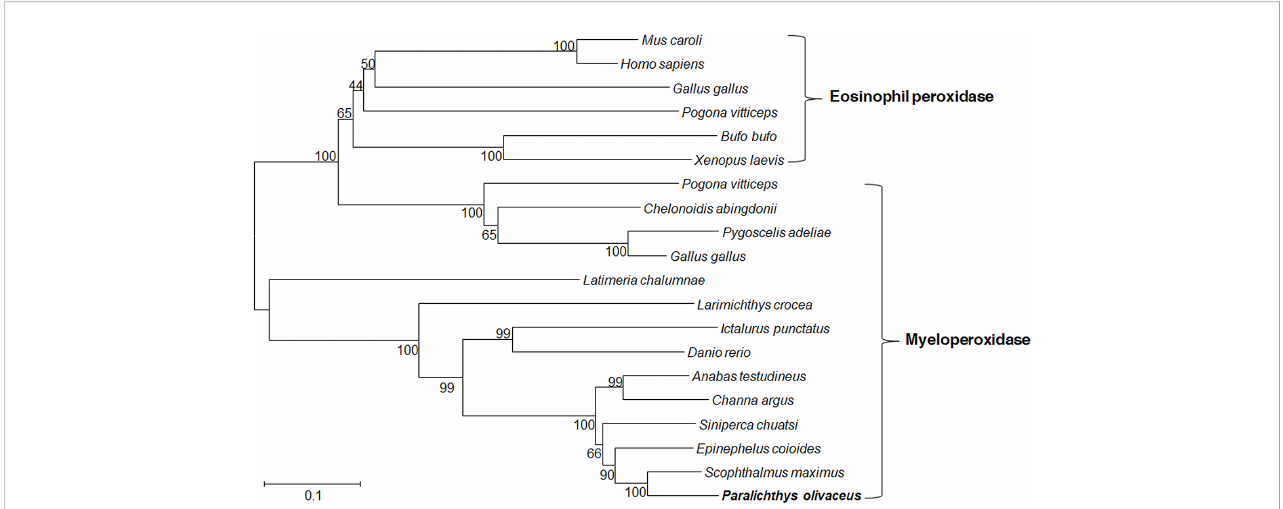
FIGURE 1 Phylogenetic tree showed the relationship between fl ounder MPO/EPO and other vertebrate amino acid MPO/EPO sequences. Numbers in each branch indicate the percentage bootstrap values from 1000 replicates. The accession numbers of MPO and EPO amino acid sequences are as follows, MPO: Paralichthys olivaceus , XP_019938121.1; Siniperca chuatsi , ABC72122.1; Danio rerio , AAK83239.1; Pogona vitticeps , XP_020659555.1; Gallus gallus , XP_015151399.1; Epinephelus coioides , APM83155.1; Channa argus , QCY41338.1; Pygoscelis adeliae , KFW66803.1 (partial); Anabas testudineus , XP_026195736.1; Larimichthys crocea , KAE8292175.1; Latimeria chalumnae , XP_005992326.1; Chelonoidis abingdonii , XP_032625834.1; Ictalurus punctatus , ACV69995.1; Scophthalmus maximus , XP_035464009.1. EPO: Gallus gallus , XP_015151415.1; Pogona vitticeps , XP_020659588.1; Homo sapiens , AAA58458.1; Xenopus laevis , NP_001081848.1; Bufo bufo , XP_040279578.1; Mus caroli ,